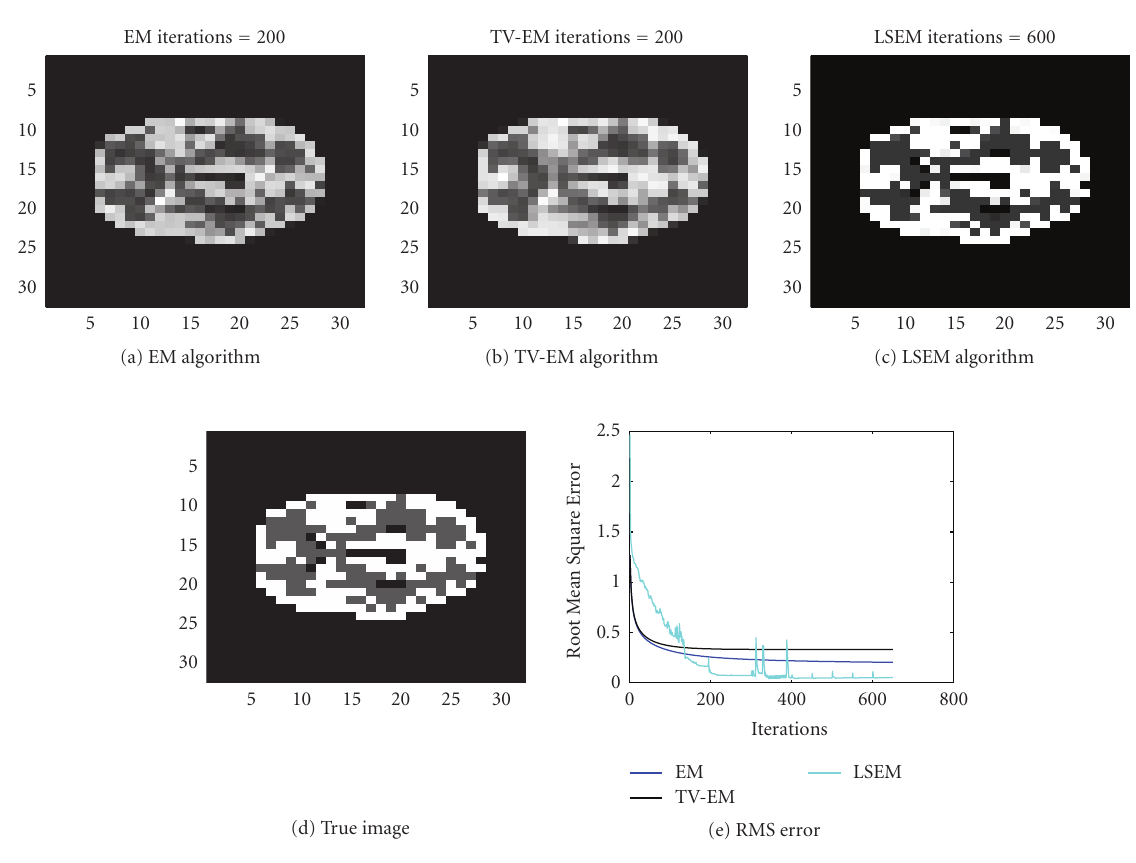
Figure 10: Construction of a PET image with di ff erent algorithms.